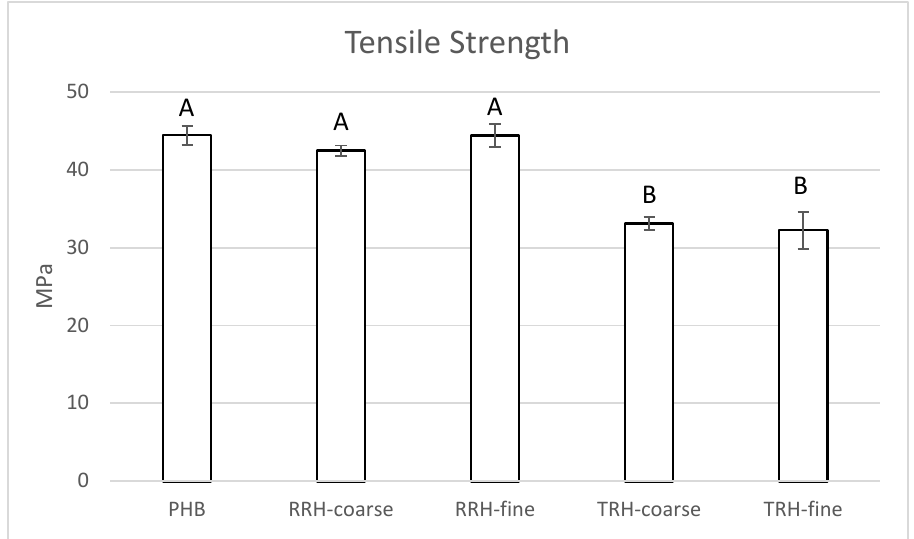
Figure 5. Tensile maximum strength measured for PHB, PHB with 10% coarse RRH, PHB with 10% fine RRH, PHB with 10% coarse TRH, and PHB with 10% fine TRH composite samples. Means with the same letter in each category are not significantly different by Tukey’s test ( α = 0.05).